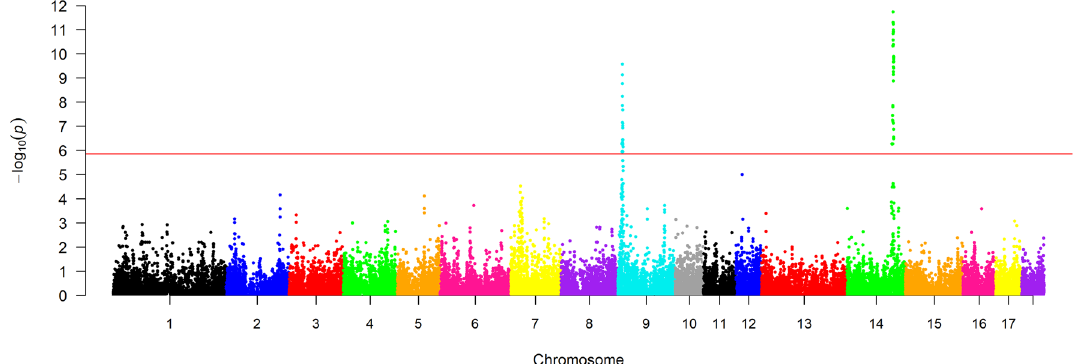
Figure 2. Genome-wide associations for palmitoleic acid content in the gluteus medius muscle. Different chromosomes are distinguished with different colours. The red line indicates the Bonferroni ‐ corrected genome ‐ wide significance